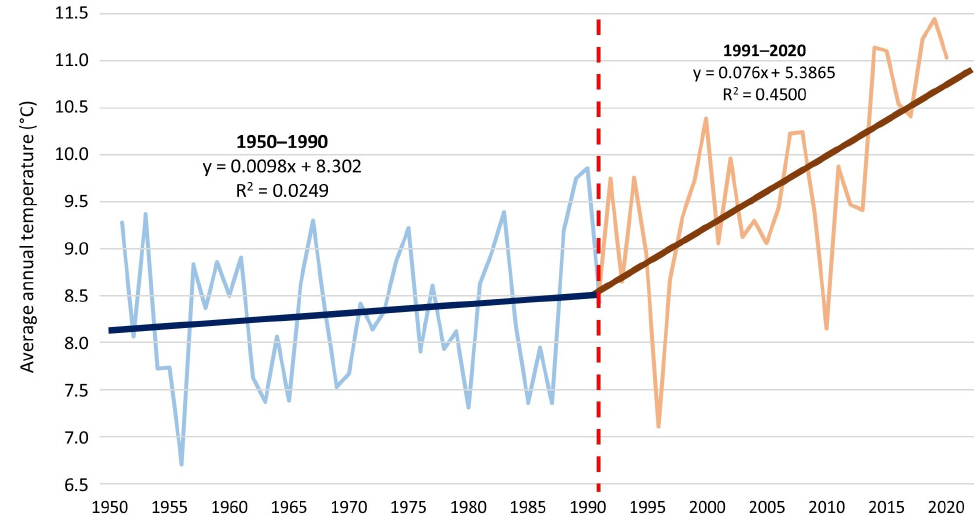
Figure 9. Mean annual air temperatures for Opole station in the period 1950–2020.